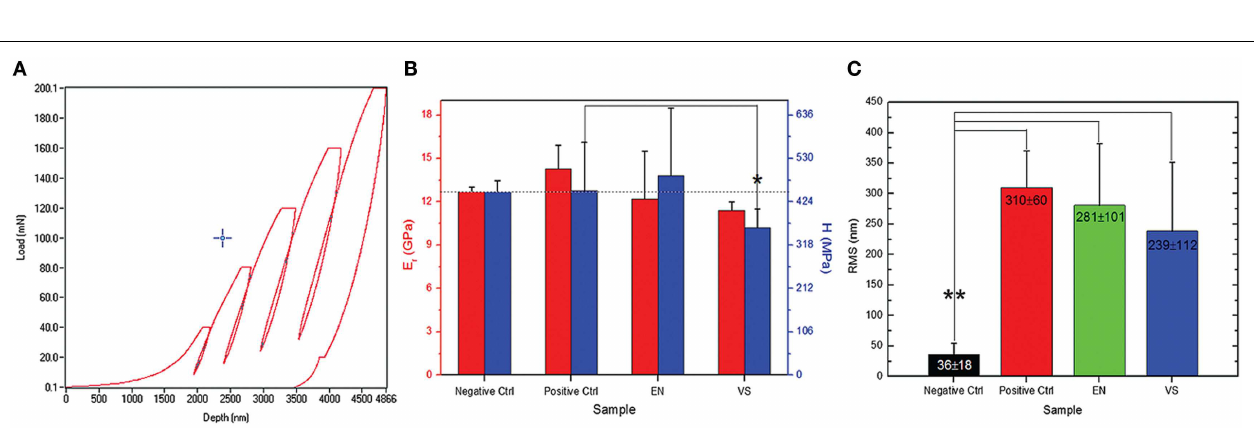
FIGURE 2 | (A,B) Representative AFM height images ofVD restoration surface after AP, at (A) 3.33 µ m and (B) 30 µ m scan size, extracted form a sequence of 0.33–90 µ m scan size in steps of geometric ratio ~3 (see the white squares as a guide to progressive zooming regions). (C) Logarithmic